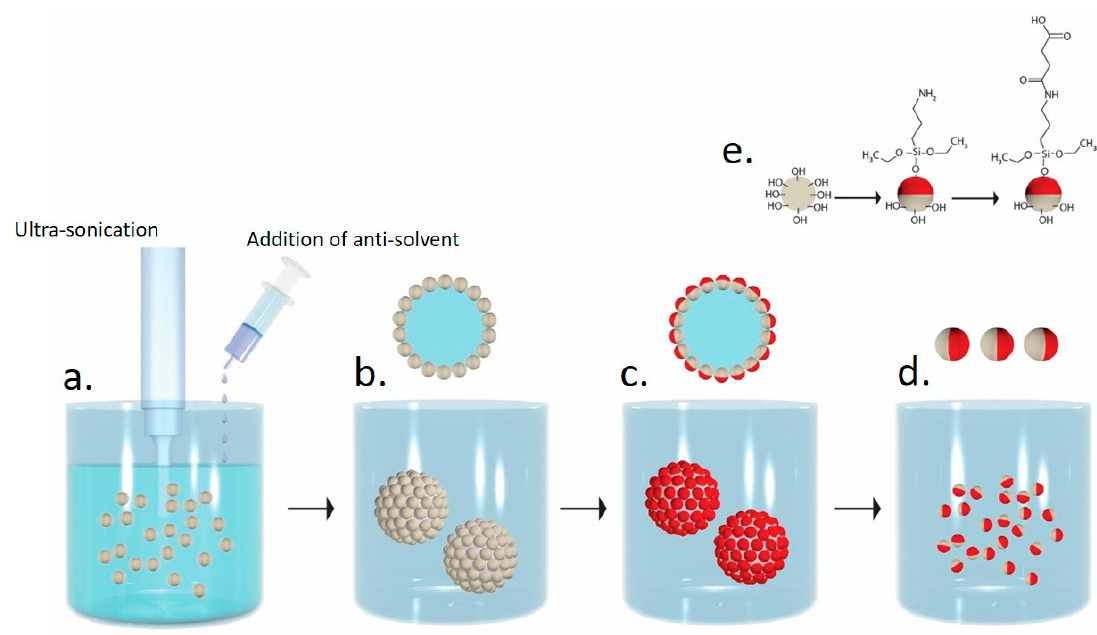
Figure 1. Schematic illustration of the new fabrication method of amphiphilic Janus particles. ( a ) Polymer precipitation by inverse solvent displacement method under an ultrasonic field in the presence of polymethylsilsesquioxane (PMSQ) particles; ( b ) PMSQ particles immobilized onto polycarbonate (PC) microspheres; ( c ) selective silanization of the PMSQ exposed hemispheres by (3-Aminopropyl)triethoxysilane (APTES); ( d ) dissolution of the PC cores for separating the PMSQ amphiphilic Janus particles from the PC; ( e ) schematic illustration of the silanization and the amidation reactions.